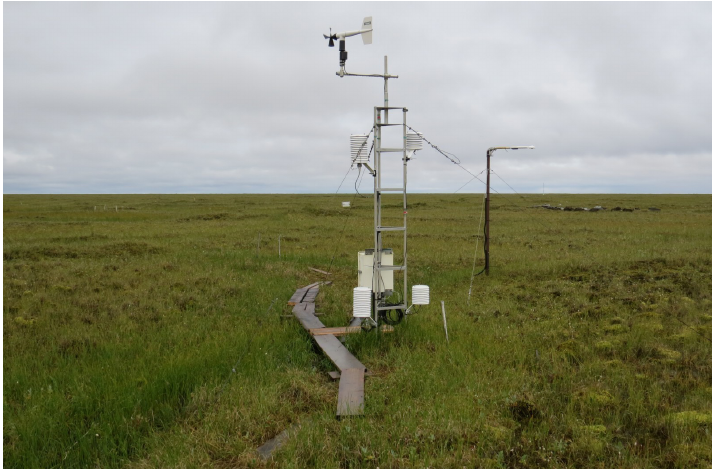
Figure B1. Samoylov meteorological station setup, August 2002–present (72.37001 ◦ N, 126.48106 ◦ E). Photo taken in August 2015. The two long radiation shields (left side of tower) at heights of 0.5 and 2m house the combined temperature and relative humidity probes (two Vaisala HMP155A sensors were installed on 17 September 2017) and the two shorter shields (right side of tower) at the same heights contain Campbell Scientific PT100 sensors (installed on 22 August 2013) to measure air temperature only. The data logger (Campbell Scientific CR1000, installed on 30 June 2009), multiplexer (Campbell Scientific AM16/32A, installed on 27 July 2010) and barometric pressure sensor (Vaisala PTP110, installed on 22 August 2014) are located in the white box at the back of the tower. The wind monitor and radiation sensor are shown in the figures below (Figs. B2 and B3).